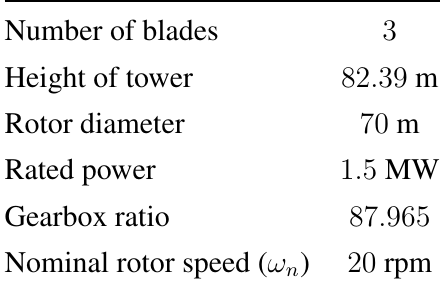
Table 1. Wind Turbine